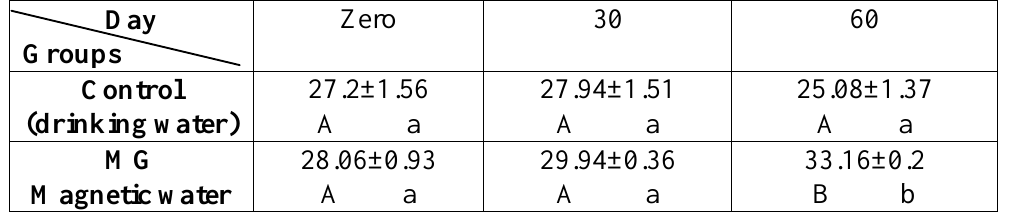
Values are expressed as mean ± SE, n = 5 each group. Capital letters denote differences between groups, P<0.05 vs. control. Small letters denote differences within group. Total Serum